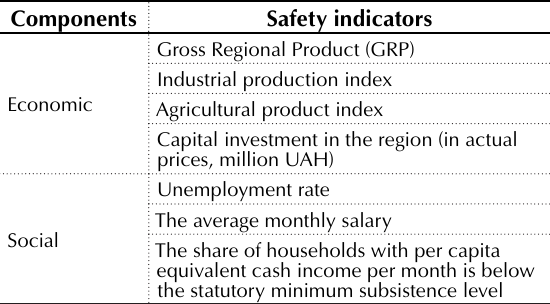
Table 1. A list of key indicators for the components of regional economic security